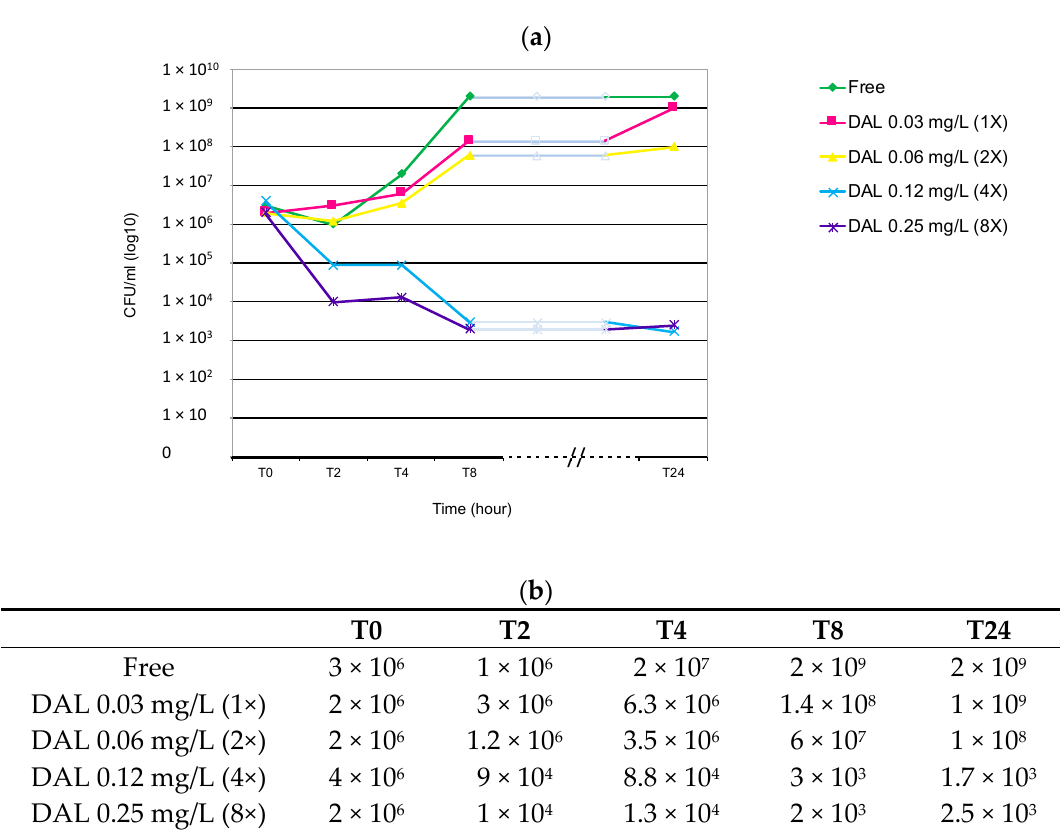
Table 2. In vitro activity of dalbavancin versus S. aureus control strains.